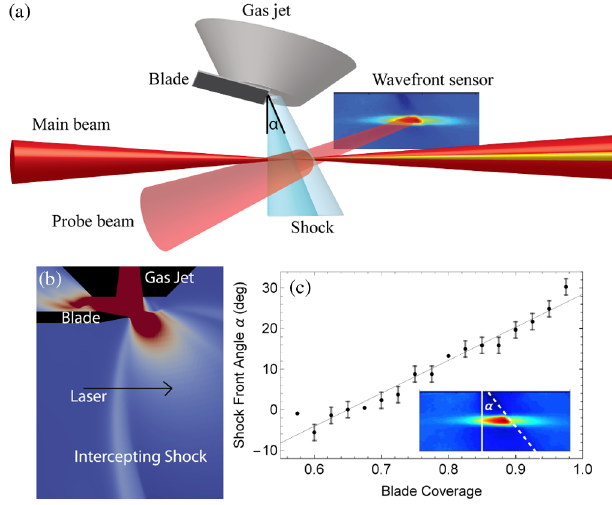
FIG. 1. (a) Schematic of the experimental setup. A razor blade was inserted into the flow of a supersonic gas jet, forming a shock. The main laser beam was focused into the shock region, producing electrons. A probe beam perpendicular to the shock front was imaged onto a wavefront sensor for density measure- ments. (b) OpenFOAM simulation of the razor blade in the gas flow showing an intercepting shock front. The color scale has been saturated to better see the intercepting shock. (c) Shock front angle versus blade coverage. The inset shows an example phase image from the wavefront sensor where the shock front angle α has been defined. The blue region is neutral density gas and the red/green is laser-ionized plasma. In both the neutral gas and plasma, the shock front can be